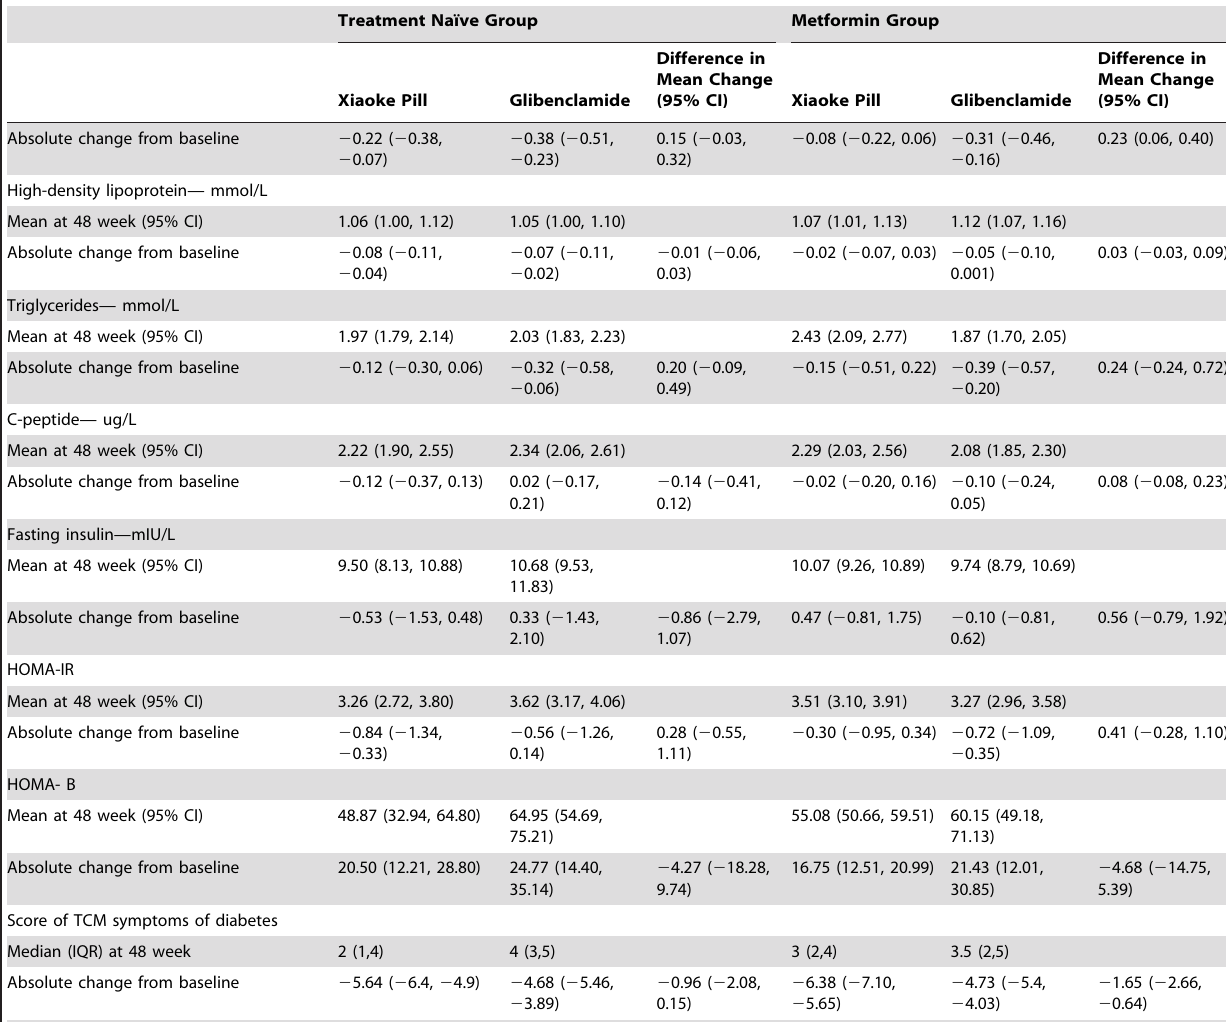
Treatment Naı¨ve Group Metformin